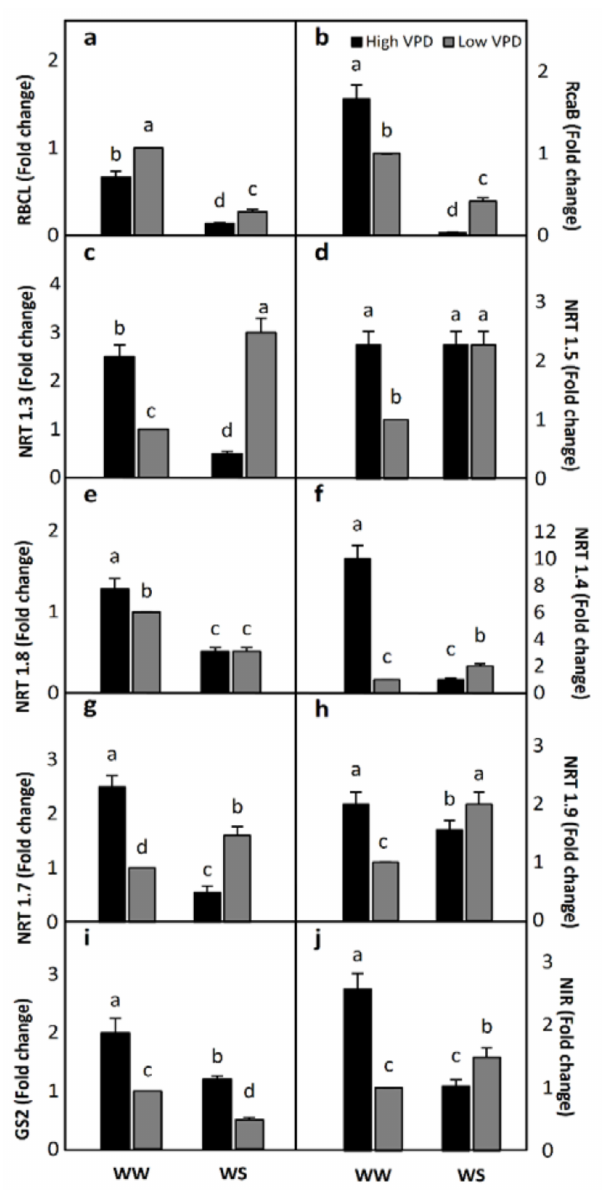
Figure 4. Effect of water irrigation (pot capacity-WW- versus 50% of pot capacity-WS) and ambient vapour pressure deficit (VPD; high versus low) on gene expression of RuBisCO ( a ) Rubisco large subunit (RBCL), ( b ) Rubisco activase β subunit (RcaB), nitrate transporters ( c ) NRT1.3, ( d ) NRT1.5, ( e ) NRT1.8, ( f ) NRT1.4, ( g ) NRT1.7, ( h ) NRT1.9, ( i ) glutamine synthetase (GS2) and ( j ) nitrite reductase (NIR) determined on wheat flag leaves. Each value represents the fold change with respect to well- watered low VPD plants. Four replications were used. Different letters above the plots indicate significant differences. Since fold change values are not normally distributed, the 95% confidence intervals are